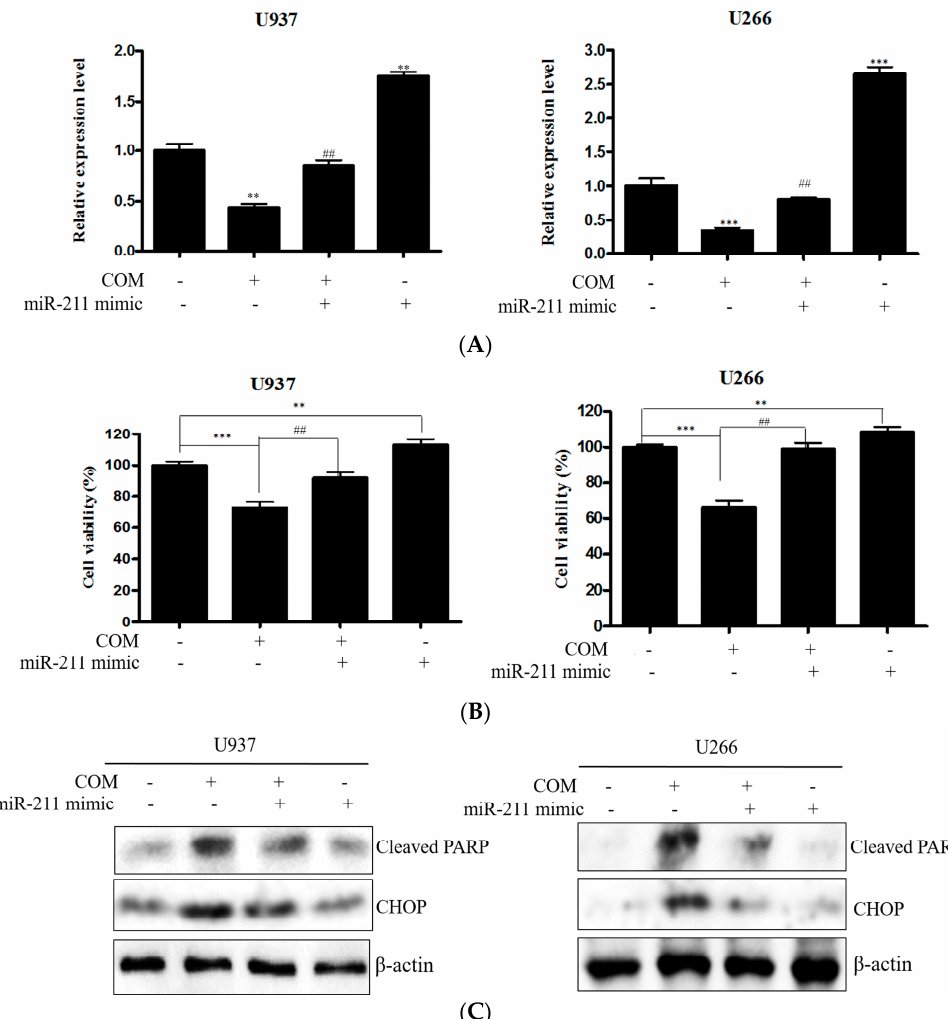
Figure 8. The effect of miR-211 in COM-induced apoptosis in U937 and U266 cells. Cells were transfected with miR-211 mimic for 48 h. ( A ) The expression level of miR-211 was determined by a qRT-PCR array after 24 h COM (80 µg/mL) treatment with or without miR-211 mimic transfection; ( B ) cell viability was determined by EZ-cytox Enhanced cell viability assay kit (80 µg/mL of COM exposure for 24 h); ( C ) Cells were treated with COM (80 µg/mL) for 24 h. Cell lysates were prepared and subjected to Western blot analysis for cleaved PARP and CHOP. Values represent the means of three experiments ± SD; ** p < 0.01, *** p < 0.001 versus untreated control; ## p < 0.01 versus COM treated group.